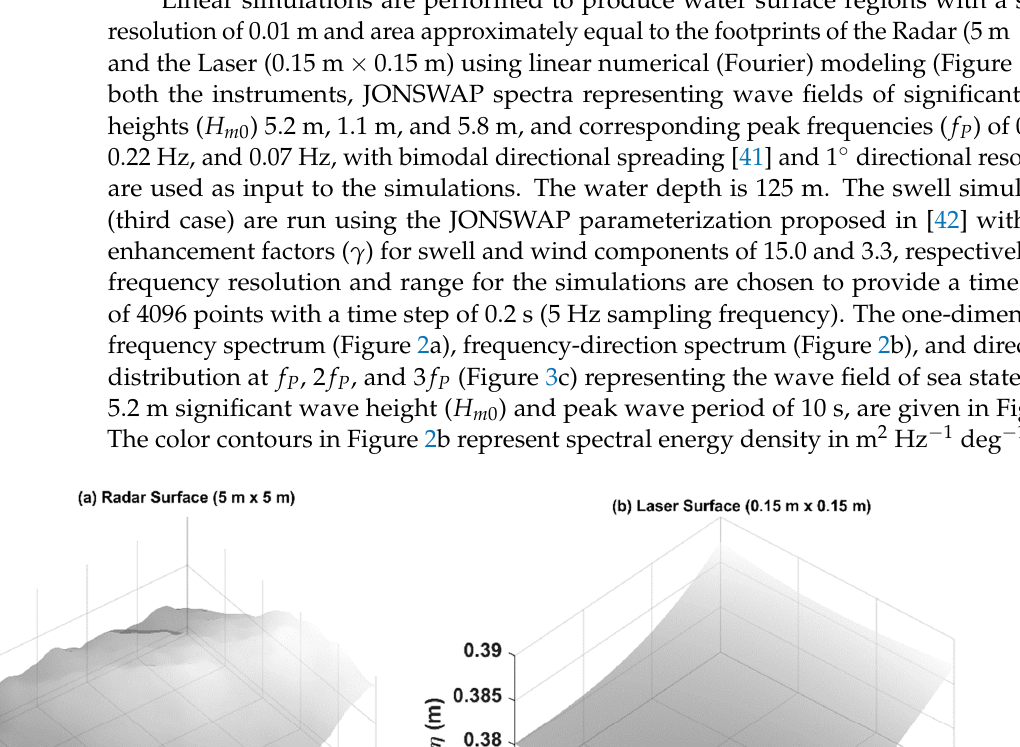
Figure 2. JONSWAP one-dimensional frequency spectrum ( a ), frequency-direction spectrum ( b ), and directional spreading ( c ). The color contours represent spectral energy density in m (cid:2870) Hz (cid:2879)(cid:2869) deg (cid:2879)(cid:2869) .